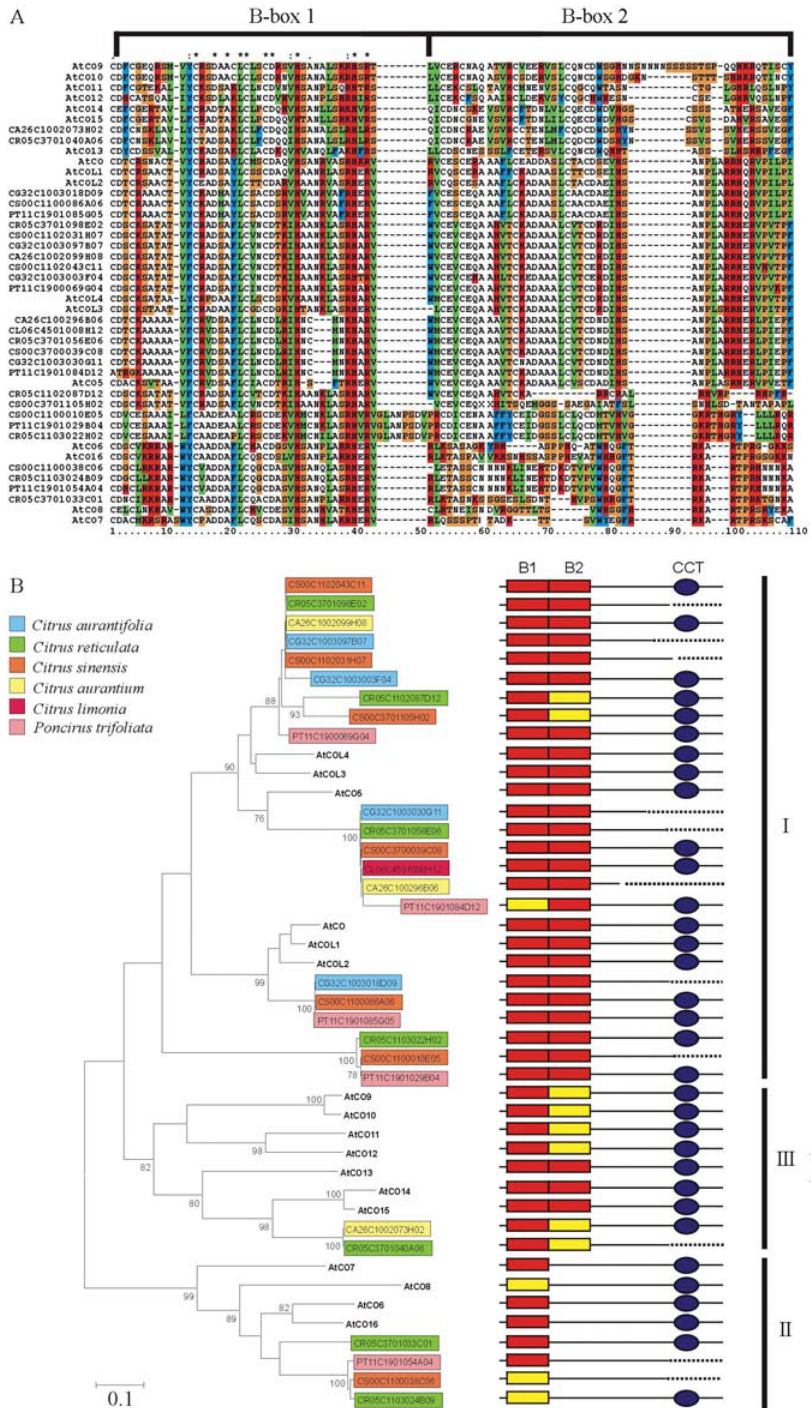
Figure 2 - Characterization of the putative CONSTANS gene family in Citrus . A . Alignment of predicted peptides of Citrus CO -like putative homologs and related genes from Arabidopsis . The region of the proteins aligned corresponds to the conserved B-box domains of the CO-like family (Robson et al. , 2001; Griffiths et al. , 2003). Amino acid colors are default of CLUSTAL software. B . Phylogenetic analysis of C O-like genes. A Neighbour-Joining tree was built basedontheofB-boxdomainalignmentshowninA.The Citrus deducedproteinnamesaregivenincoloredboxes.Geneticdistancesareshownatthegiven scale. Bootstrap values from 1,000 replicates were used to assess the robustness of the trees. Only bootstrap values above 75% are shown. The domain struc- tures of each protein is also shown to the right side of their names. B1 and B2 are C O-like B-boxes (white rectangles) or derived zinc finger domains (solid rectangles).CCTistheconservedCCTcarboxy-terminusdomain(Robson etal. ,2001).Thedottedlinesrepresentincompletesequences. Arabidopsis MIPS codes are as follows: AtCO (At5g15840); AtCOL1 (At5g15850); AtCOL2 (At3g02380); AtCOL3 (At2g24790); AtCOL4 (At5g24930); AtCOL5 (At5g57660); AtCOL6 (At1g68520); AtCOL7 (At1g73870); AtCOL8 (At1g49130); AtCOL9 (At3g07650); AtCOL10 (AB023039); AtCOL11 (At4g15250); AtCOL12 (At3g21880); AtCOL13 (At2g47890); AtCOL14 (At2g33500); AtCOL15 (At1g28050); AtCOL16